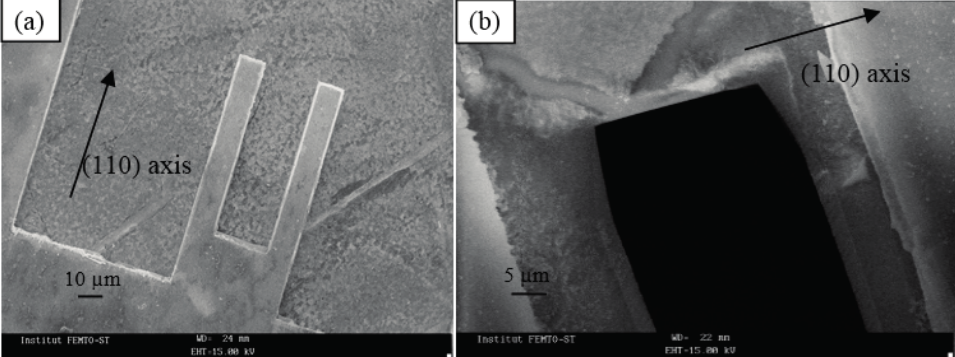
Figure 7. SEM images of chemically etched microcantilevers. The cantilever is covered by a chemically inert mask: ( a ) coupled cantilevers; ( b ) magnification of the structure: underetching under the